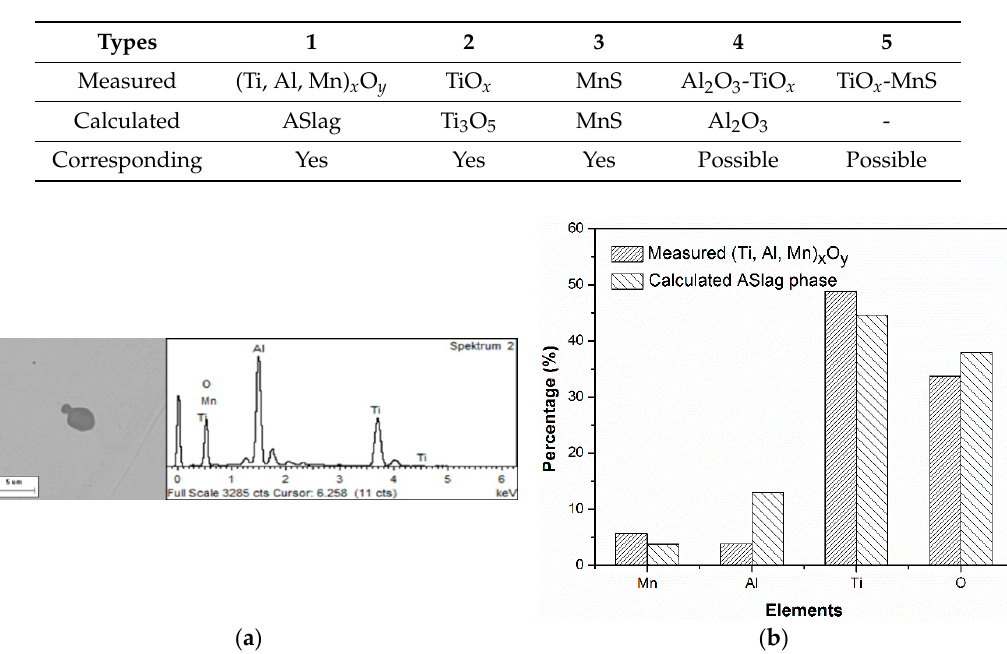
Figure 4. ( a ) Morphology and EDS analysis of (Ti, Al, Mn) x O y ; ( b ) comparison of the composition of the calculated ASlag and measured (Ti, Al, Mn) x O y . Reproduced with permission from [15], ISIJ International,